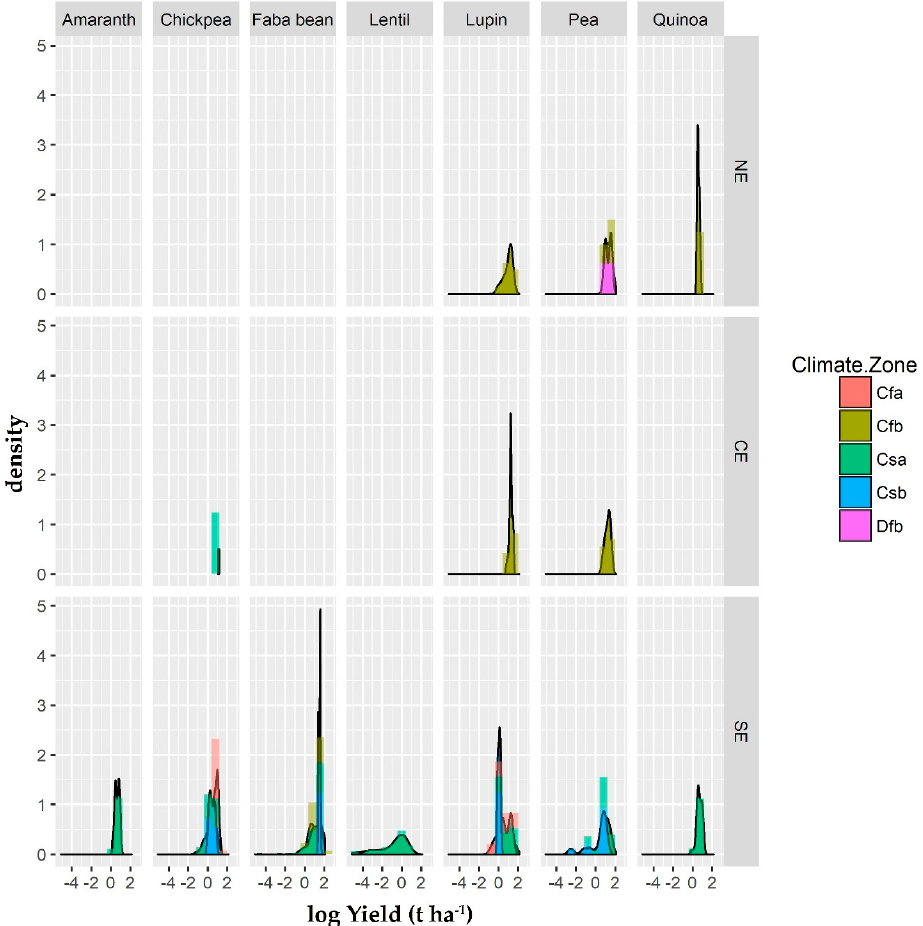
Figure 5. Distribution frequencies of log yield (t ha − 1 ) for all observations (n = 817) by crops (amaranth, chickpea, faba bean, lentil, lupin, pea, and quinoa) and European regions (northern (NE), central (CE), and southern (SE)) grouped by climate zone (Cfa: Humid subtropical; Cfb: Marin–mild winter; Csa: interior Mediterranean; Csb coastal Mediterranean; Dfb: humid continental mild summer, wet all